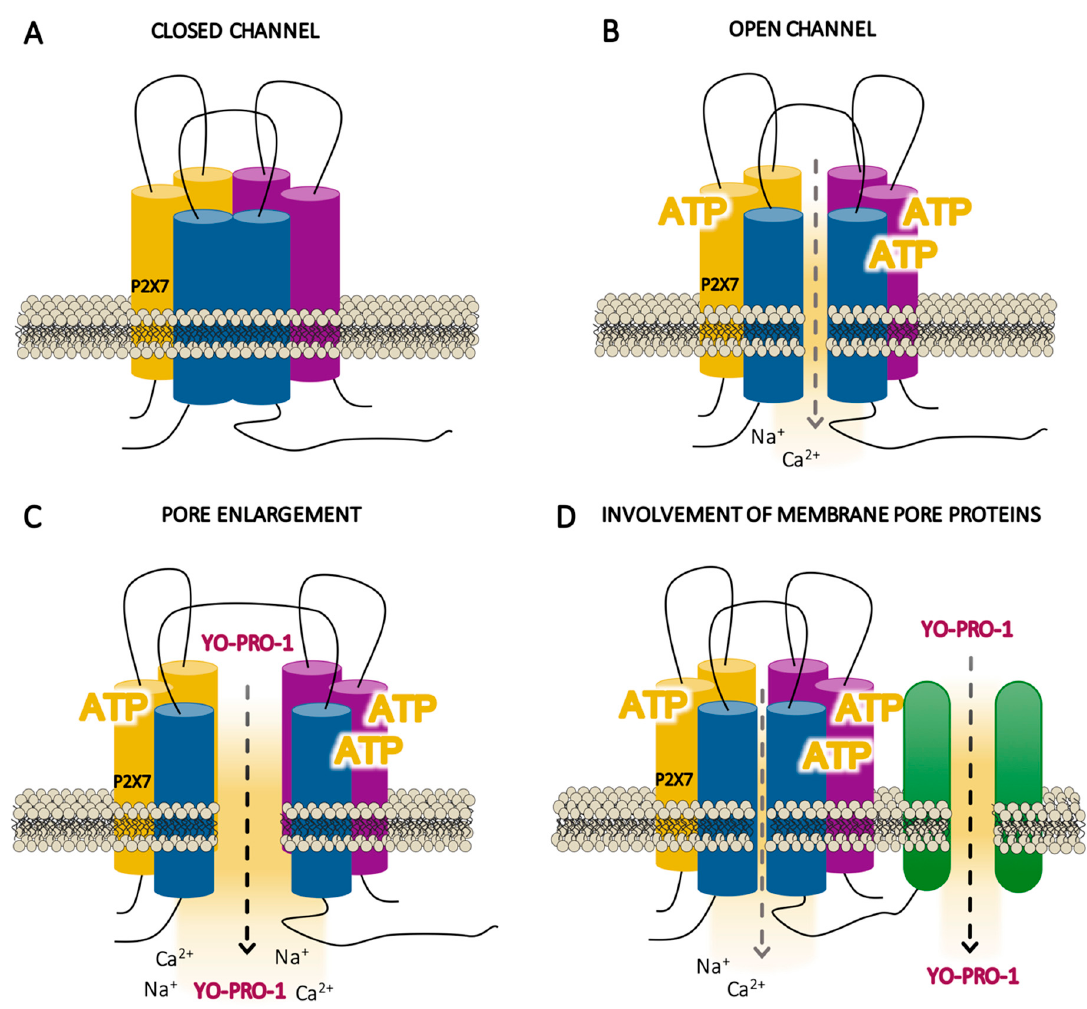
Figure 3. Schematic illustrations of the hypothetical states of the P2X7 receptor (P2X7R) activation. ( A ) Resting state of the P2X7R where the agonist (adenosine triphosphate, ATP) is not present or exists in insufficient concentrations, so that the conformation of the receptor does not open its own ion channel (closed channel). ( B ) Initial activation of the receptor within milliseconds by the three molecules of ATP, inducing a selective channel opening for small cations (open channels). ( C ) This initial state is followed by a prolonged phase within seconds to a minute of enlargement of the receptor itself (pore enlargement), allowing the flux of non-selective large ions such as Yo-Pro-1. ( D ) This prolonged phase of activation can involve other membrane proteins.